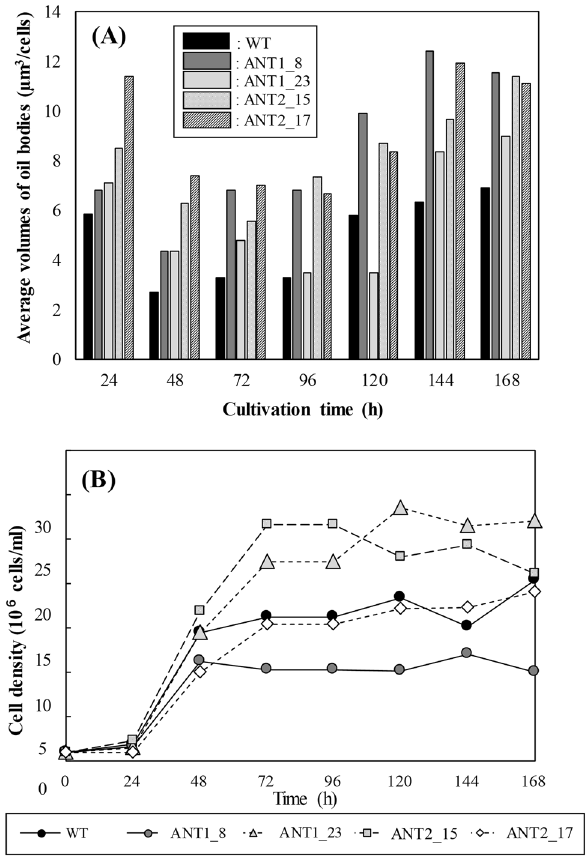
Figure 1. Time-course variation of oil body volumes ( A ) and cell concentrations ( B ) in F. solaris wild type (WT) and transformants (ANT1_8 and ANT1_23 for pSP-ANT1, and ANT2_15, and ANT2_17 for pSP- ANT2). The cells were cultured in conical flasks containing 50 mL of f/2 medium (the initial cell concentrations of 1 × 10 6 cells/mL) at 25 °C under continuous illumination at 50 µmol photons/m 2 /s on the shaker (~ 120 rpm). G-418 (500 μg/mL) was added to the culture of the transformant clones.